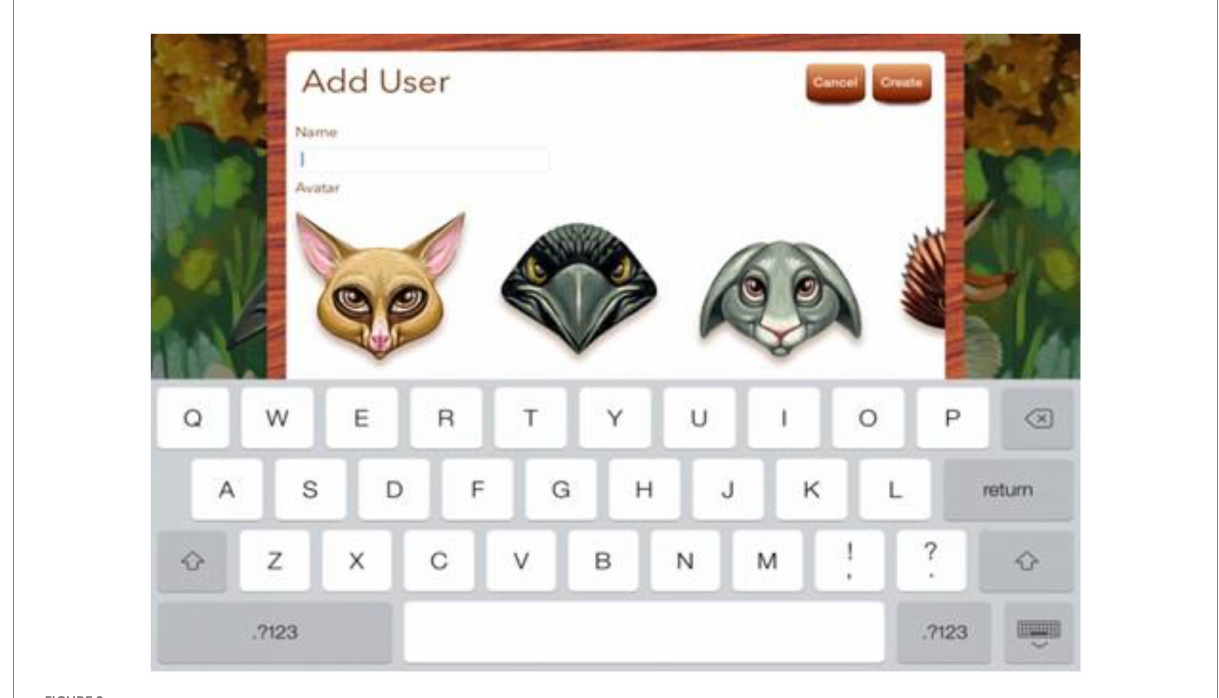
FIGURE 2 Add user screen in app with choice of six